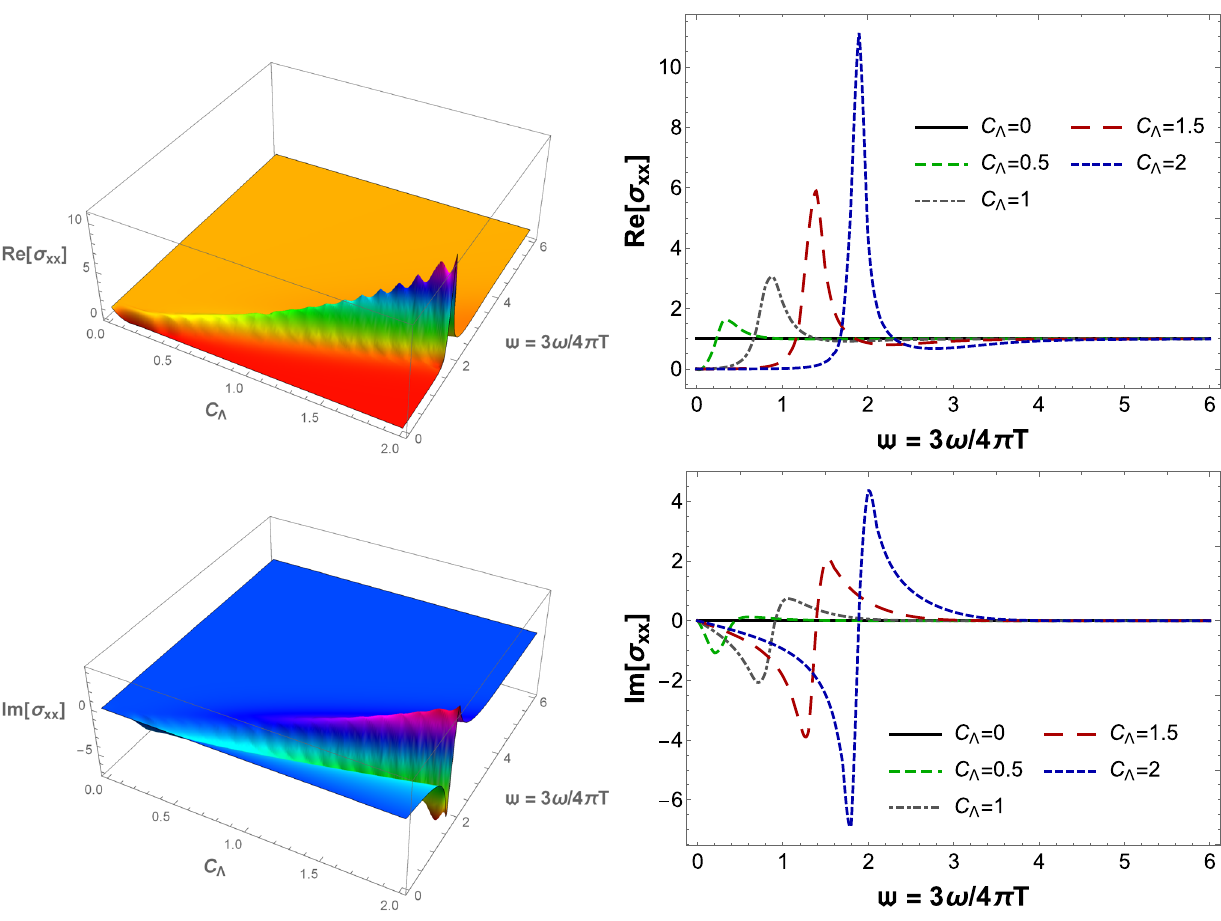
Fig. 9 Real and imaginary parts of the diagonal AC conductivity as functions of ( C (cid:12) = (cid:12) L / 2 , w = 3 ω/ 4 π T ) at fixed θ = 1. These results were generated with the mass function M ( u ) = tanh ( u )